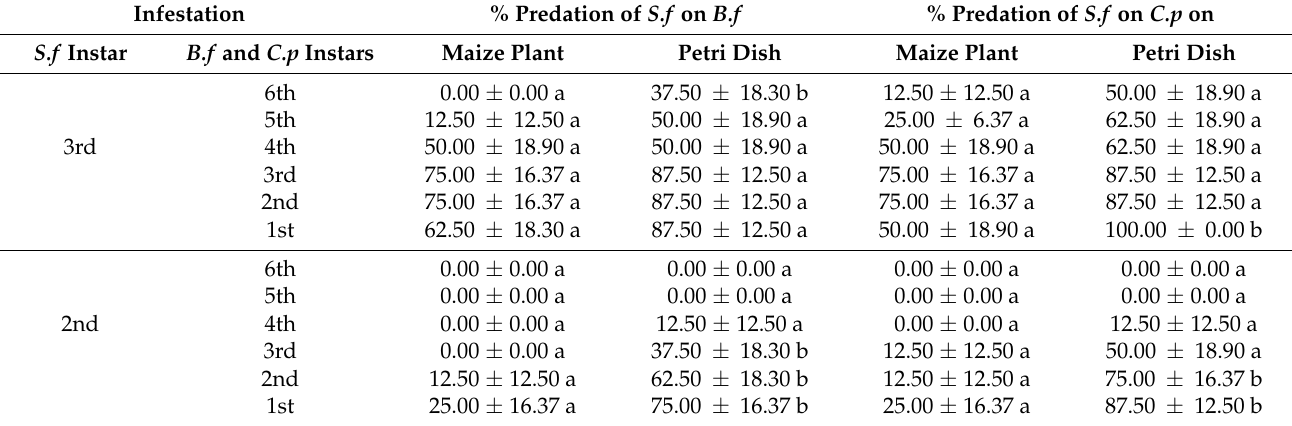
Key: S.f ( Spodoptera frugiperda ), B.f (Busseola fusca), and C.p ( Chilo partellus ). Different lowercase letters along the same row reflect statistically significant differences between predation of Spodoptera frugiperda on Busseola fusca and Chilo partellus on both maize plant and Petri dish ( p < 0.05).